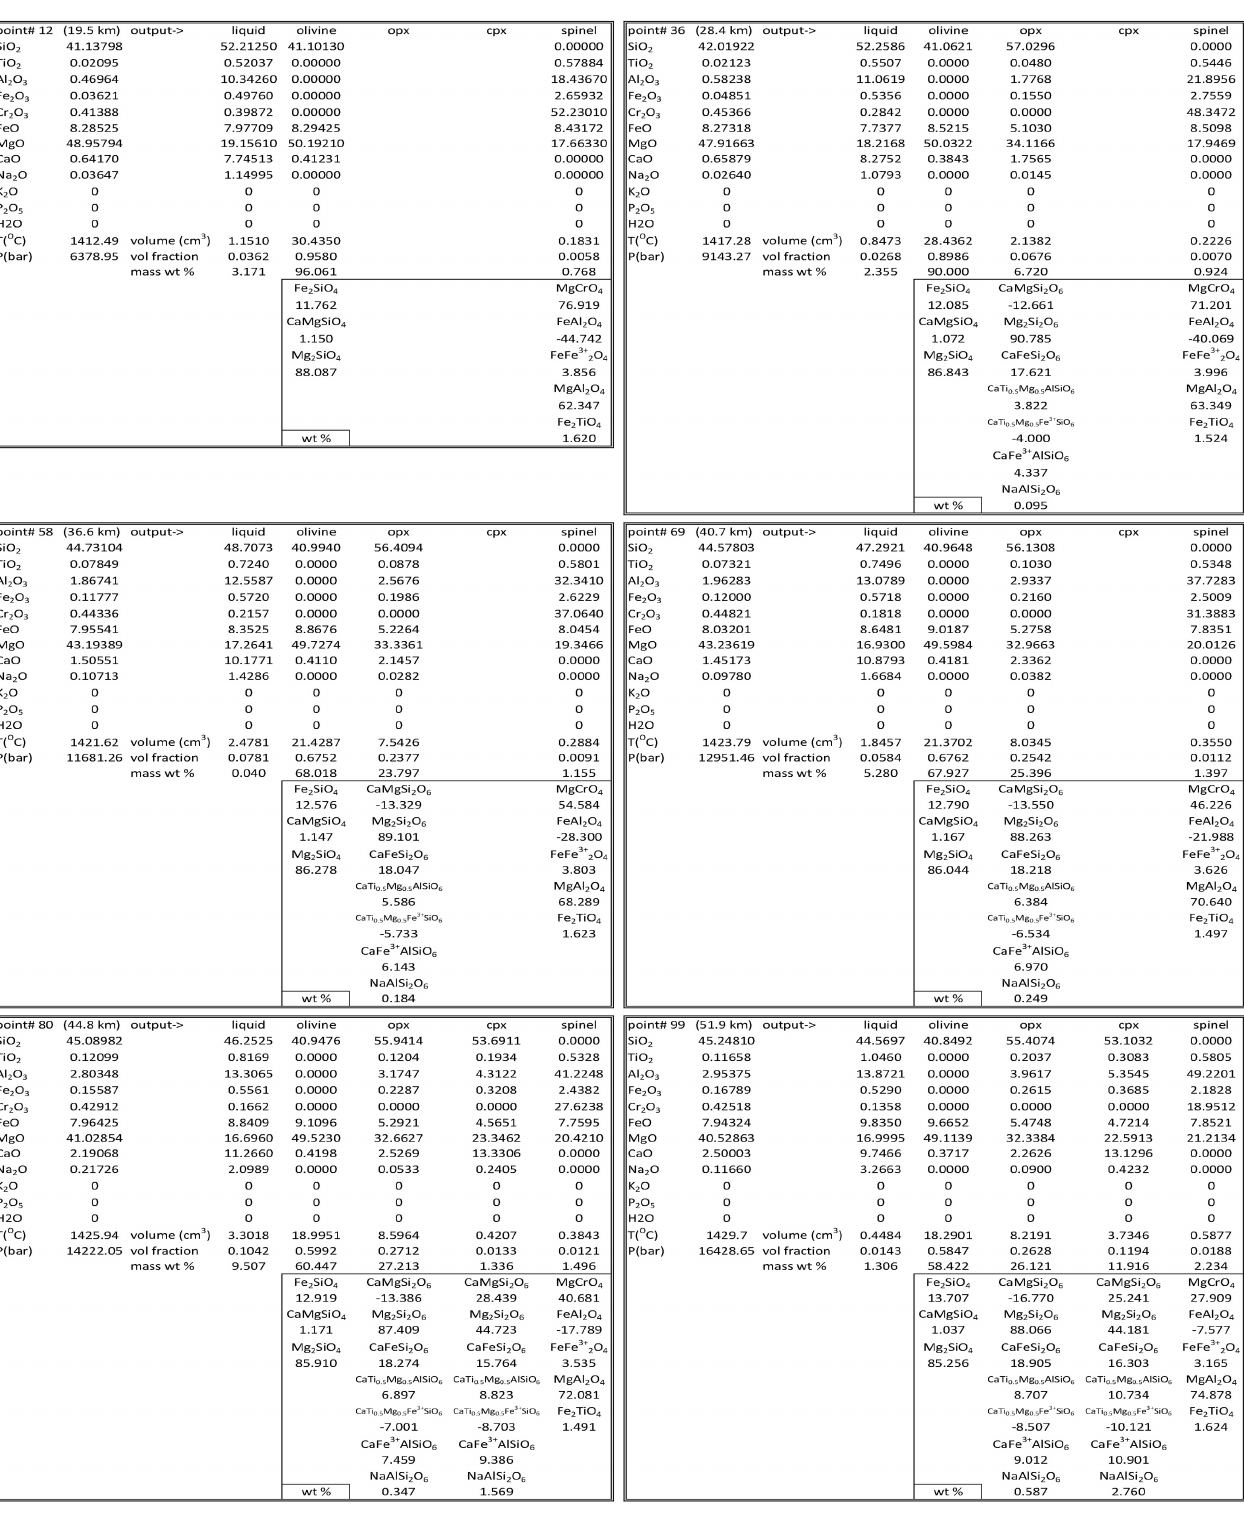
TABLE 2 | Mineral data at 6 depths for the model shown in Figure 4